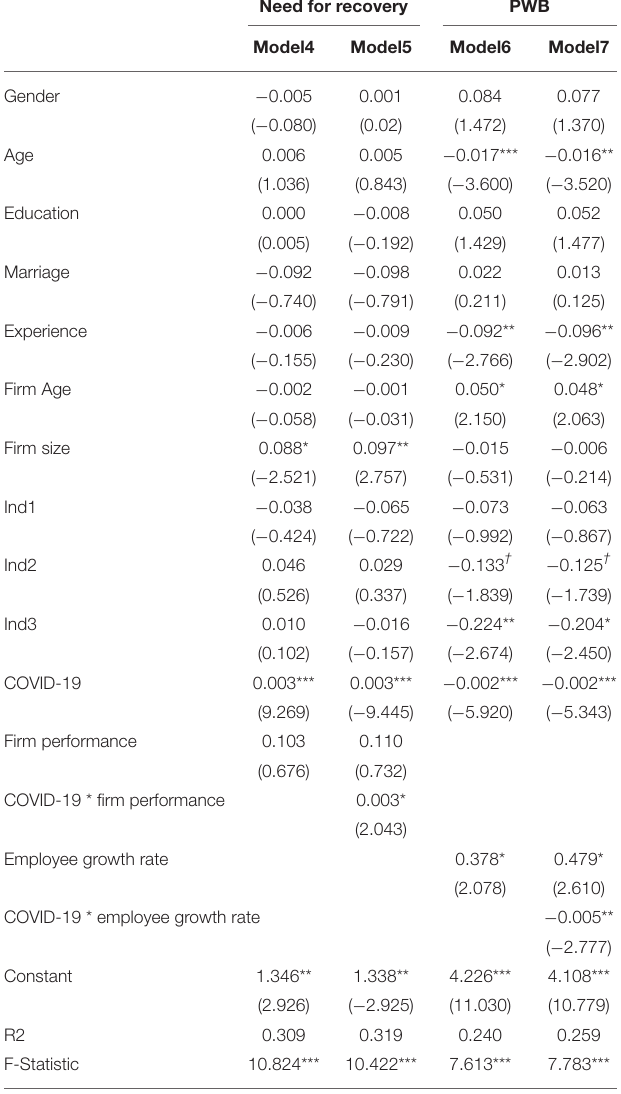
TABLE 4 | Regressive results of robustness